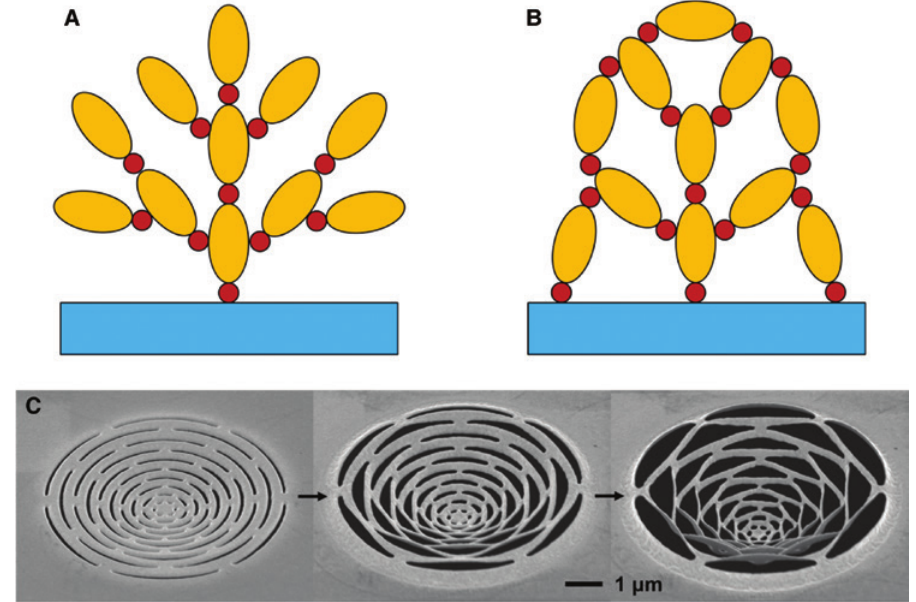
Figure 2: Schematic of the topological classifications of multibody systems that can be used to differentiate the types of nano-kirigami methods [41, 42].